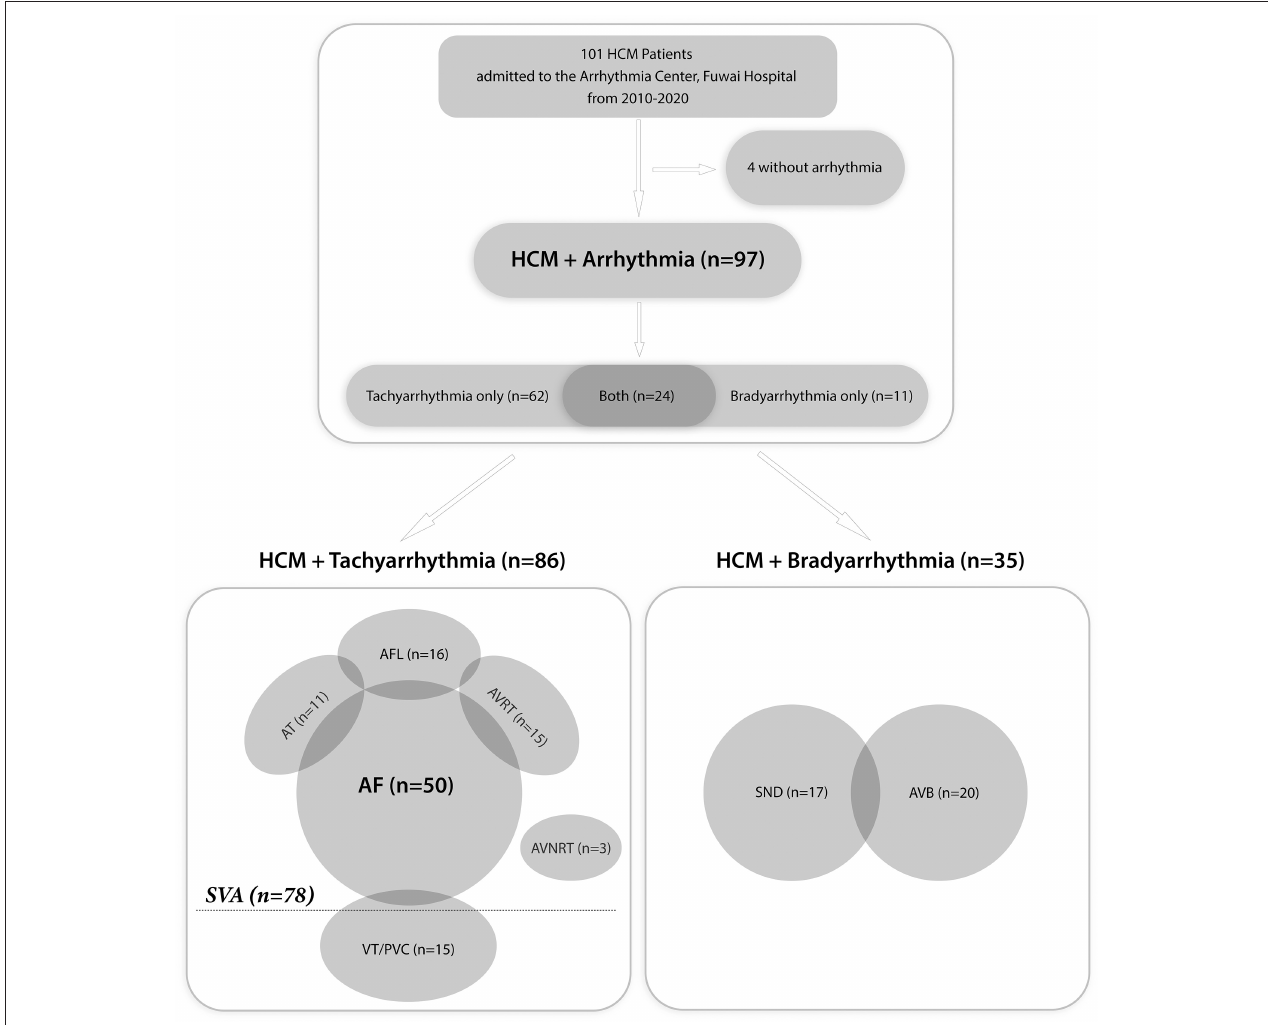
FIGURE 1 | Flow chart of all patients with arrhythmias. HCM, hypertrophic cardiomyopathy; SVA, supraventricular tachyarrhythmia; AF, atrial fibrillation; AFL, atrial flutter; AT, atrial tachycardia; AVRT, atrioventricular reentrant tachycardia; AVNRT, atrioventricular nodal reentrant tachycardia; VT, ventricular tachycardia; PVC, premature ventricular contraction; SND, sinus node dysfunction; AVB, atrioventricular